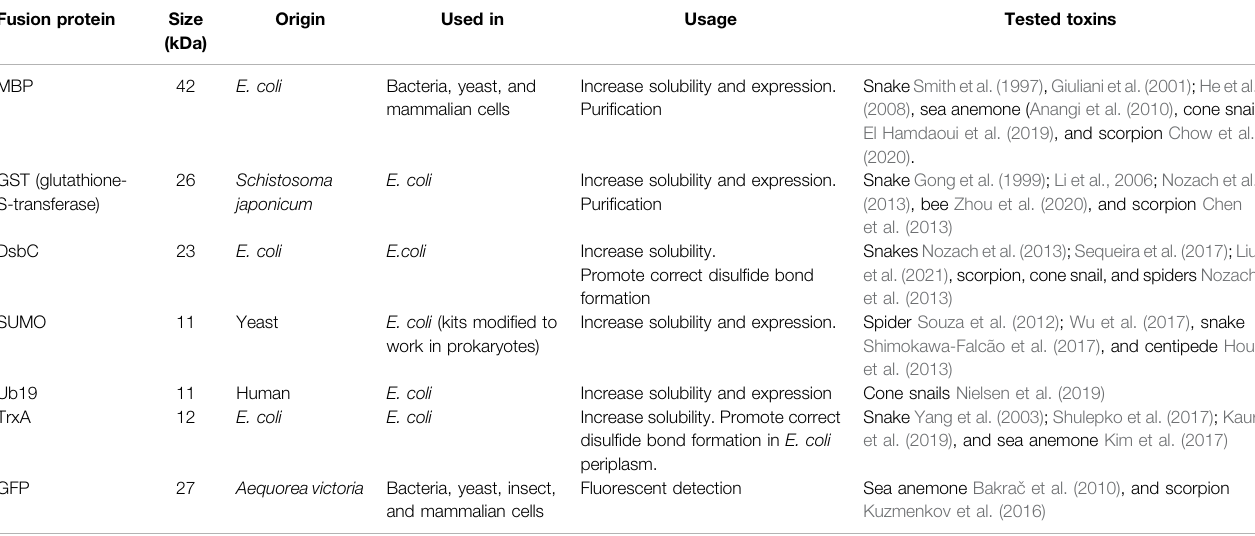
TABLE 1 | Summary table of the most widely used fusion proteins for recombinant expression of toxins. Fusion